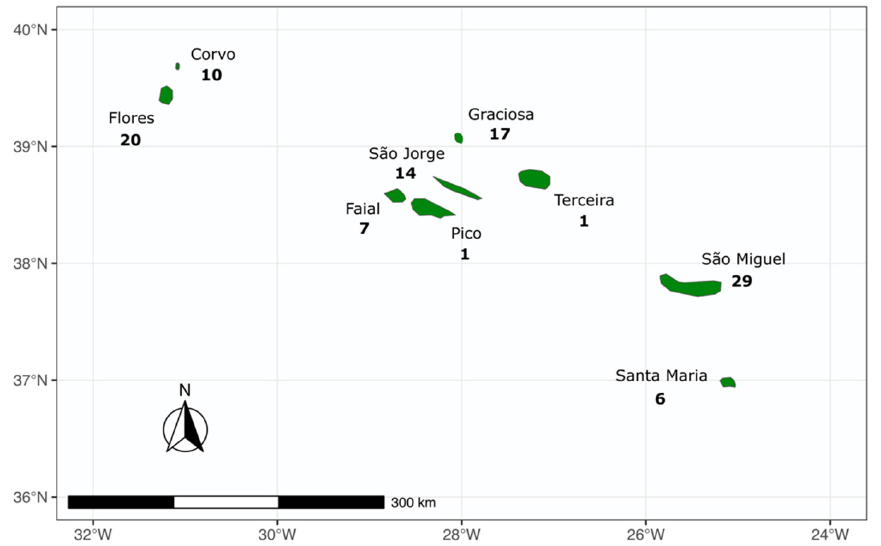
Figure 1. Spatial coverage of the sampling procedure performed in the Azores archipelago involving fishers. The numbers indicate the absolute sample size ( n ).